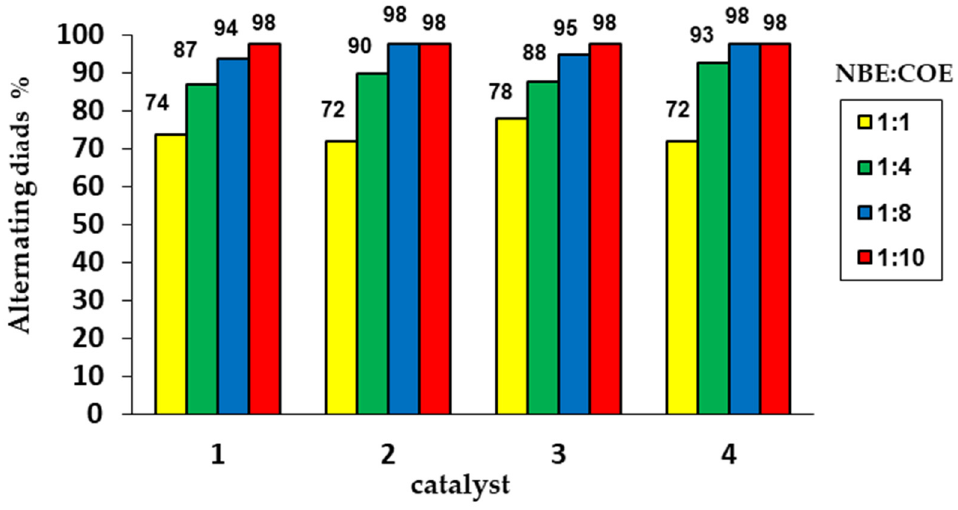
time 2 min. 2 Fractions of homopolymer sequences in the copolymer. 3 Determined using 13 C-NMR. The value in parenthesis is the percentage of cis double bonds. 4 Determined using THF size-